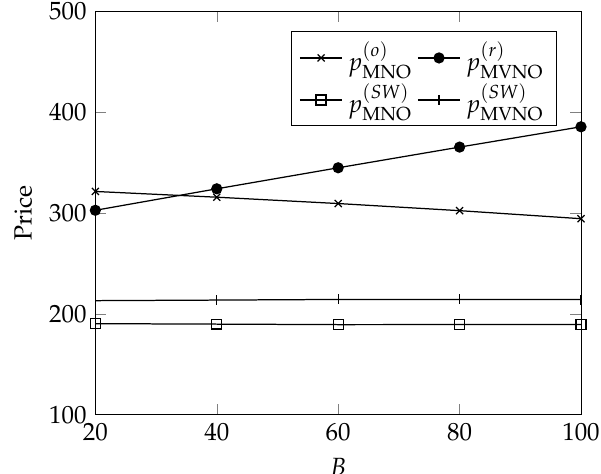
Figure 6. Price set by the owner ( p